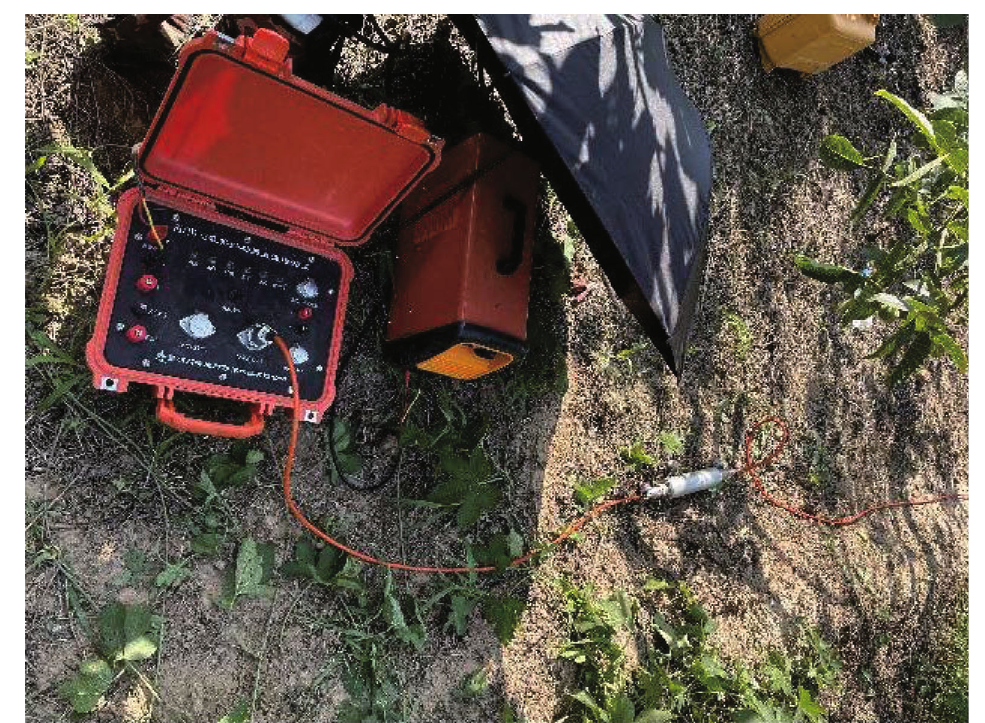
Figure 2: The selected